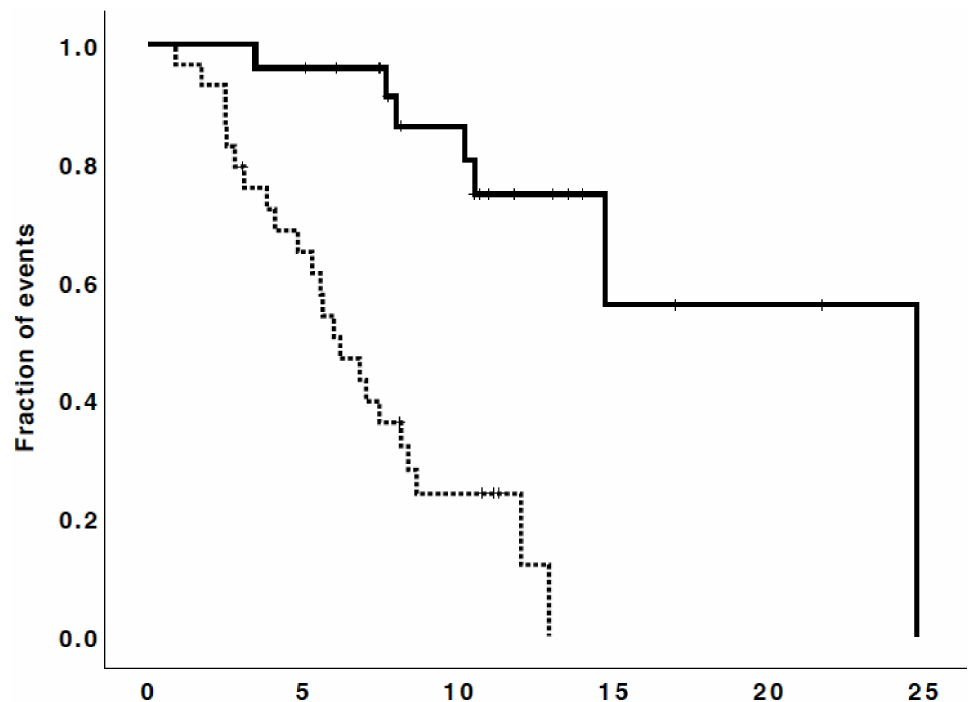
Figure 5. Survival curves of the patients reporting a disease control (continuous line, median OS of 24.8 months) and the patients with progressive disease (dashed line, median OS of 6.2 months) ( p =